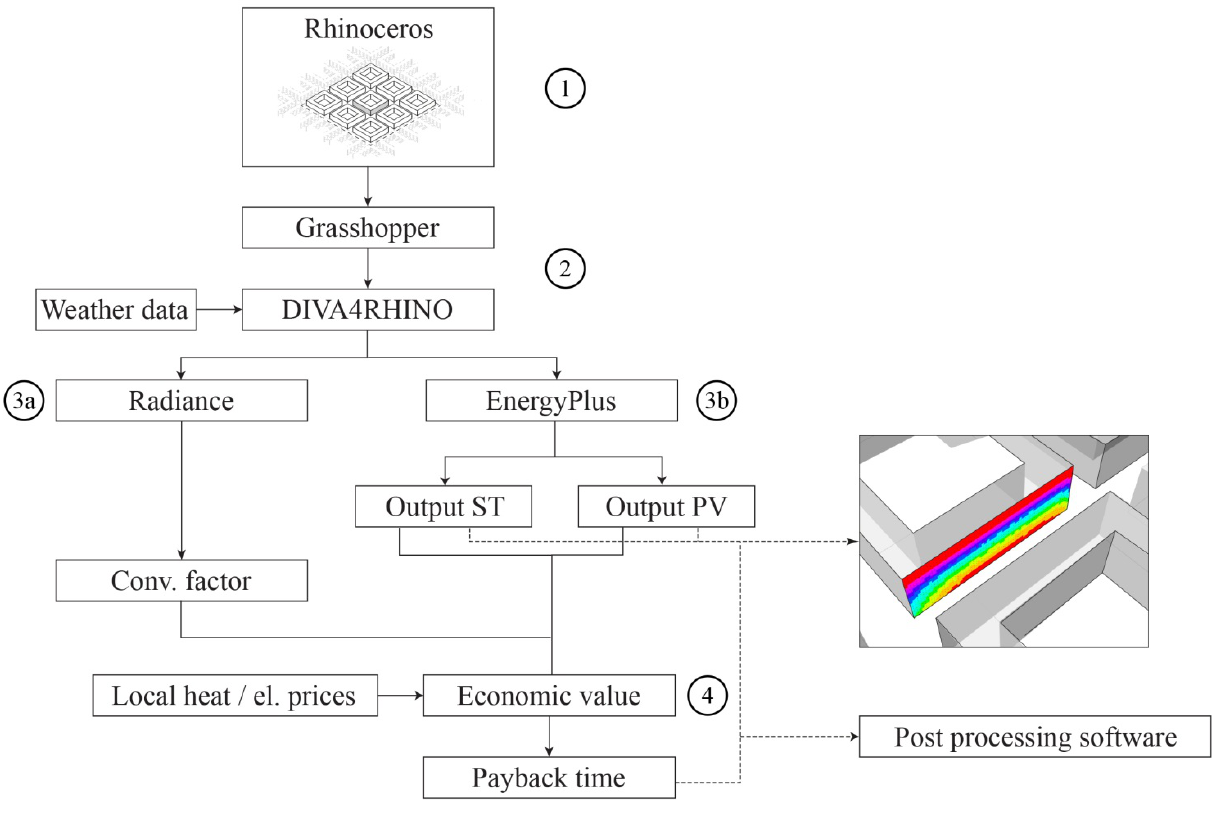
Figure 1. Workflow of the FASSADES